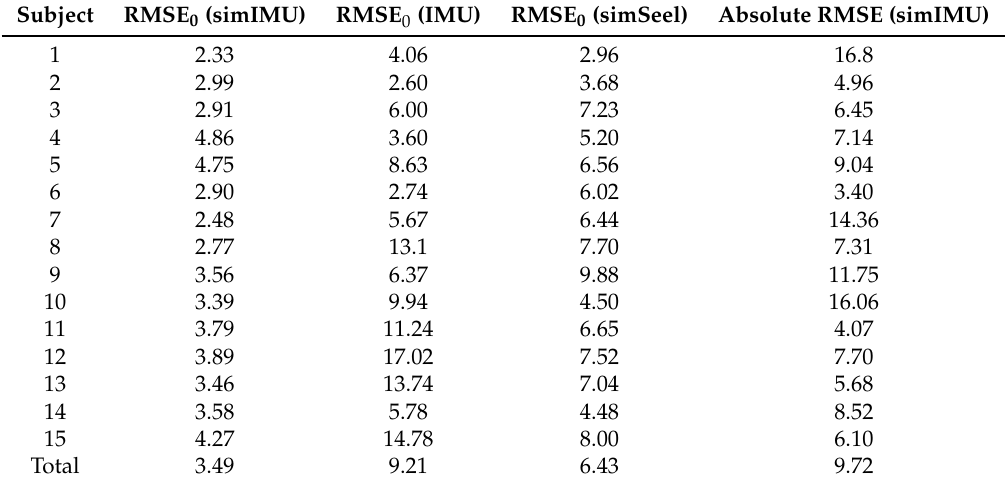
Table 1. RMSE in degrees by subject for selected analyses: zero-mean RMSE of the simulated IMU knee angle with the proposed method, zero-mean RMSE of the actual IMU data with the proposed method, zero-mean RMSE of the Seel et al. method [30] on the simulated IMU data, and absolute RMSE of the simulated IMU data with the proposed